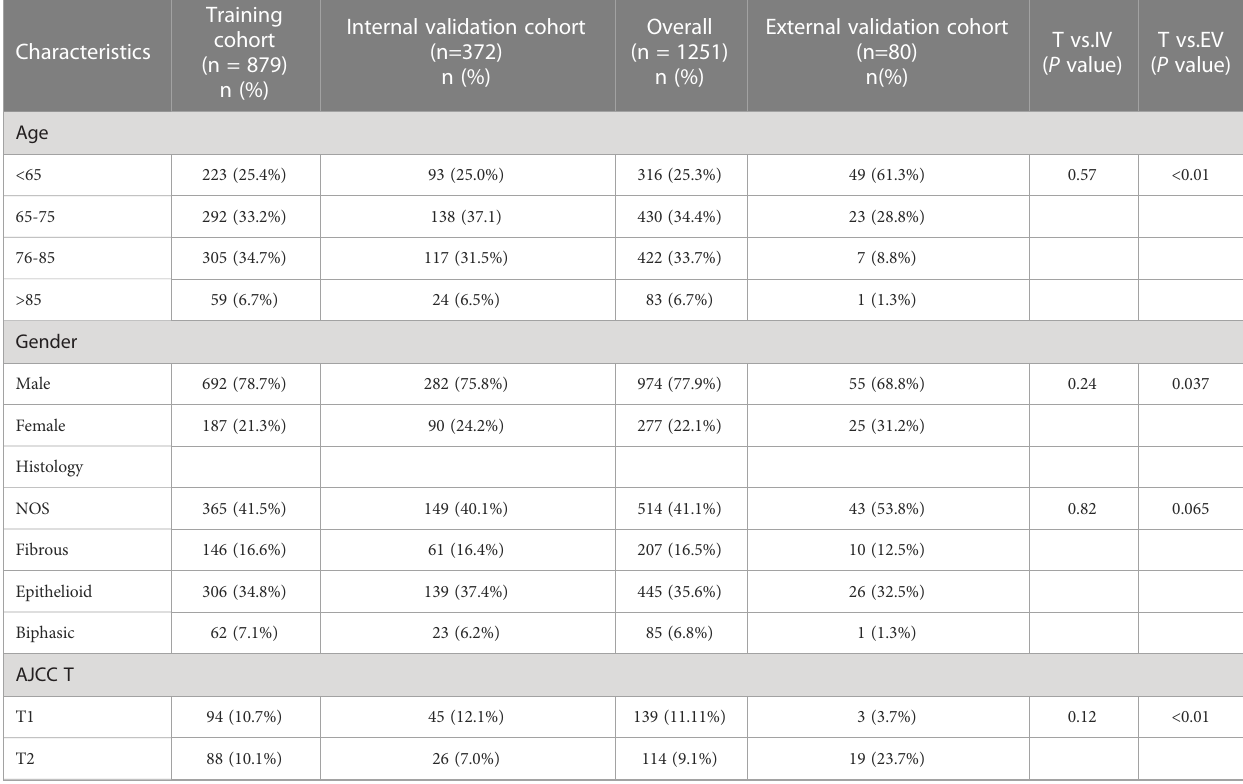
TABLE 1 Demographics and clinicopathologic characteristics of the training and external validation cohort.